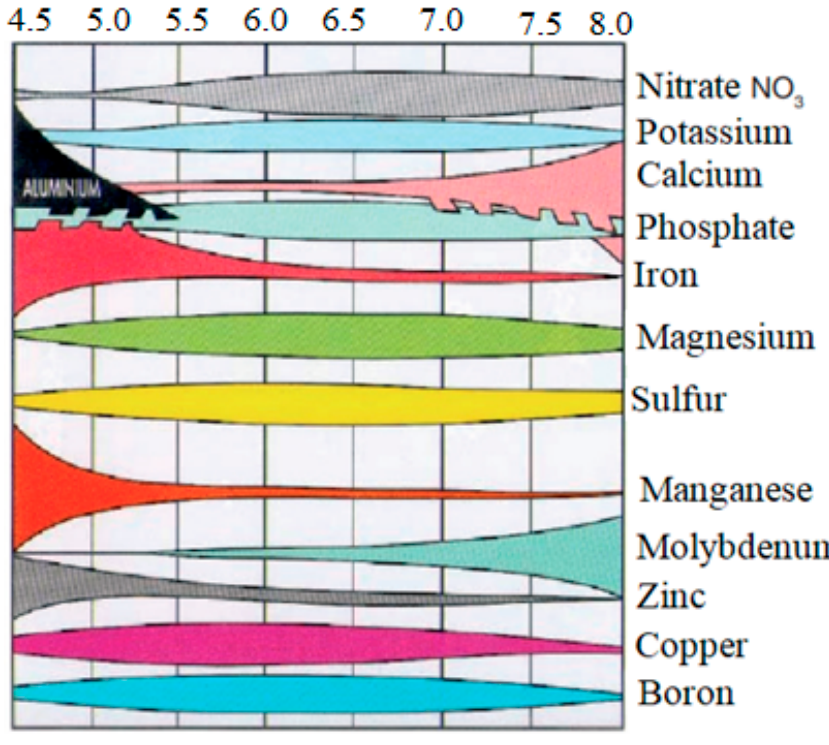
Figure 6. Assimilation of nutrients by plants depending on soil pH (adapted from [57]).